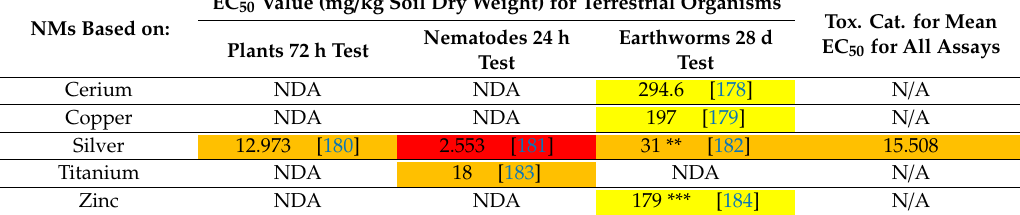
Table 9. Comparison of EC 50 values for some NMs and classification in terrestrial toxicity categories. The classification into toxicity categories is color-coded as follows: values that are in the VT / A1 category have red shading, in T / A2 have orange shading and in H / A3 have yellow shading. EC 50 Value (mg / kg Soil Dry Weight) for Terrestrial Organisms Tox. Cat. for Mean NMs Based on: Earthworms 28 d EC 50 for All AssaysPlants 72 h Test Nematodes 24 h Test Test Cerium NDA NDA 294.6 [178] N / A Copper NDA NDA 197 [179] N / A Silver 12.973 [180] 2.553 [181] 31 ** [182] 15.508 Titanium